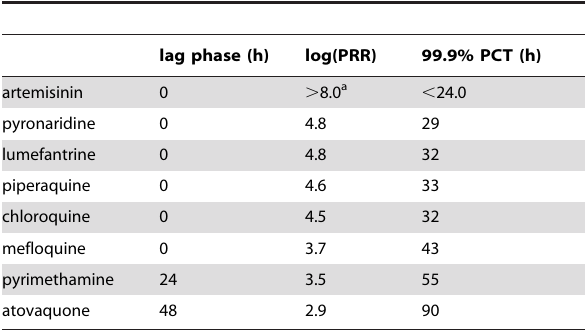
Table 1. In vitro parasite reduction ratio and clearance time in response to classical antimalarial